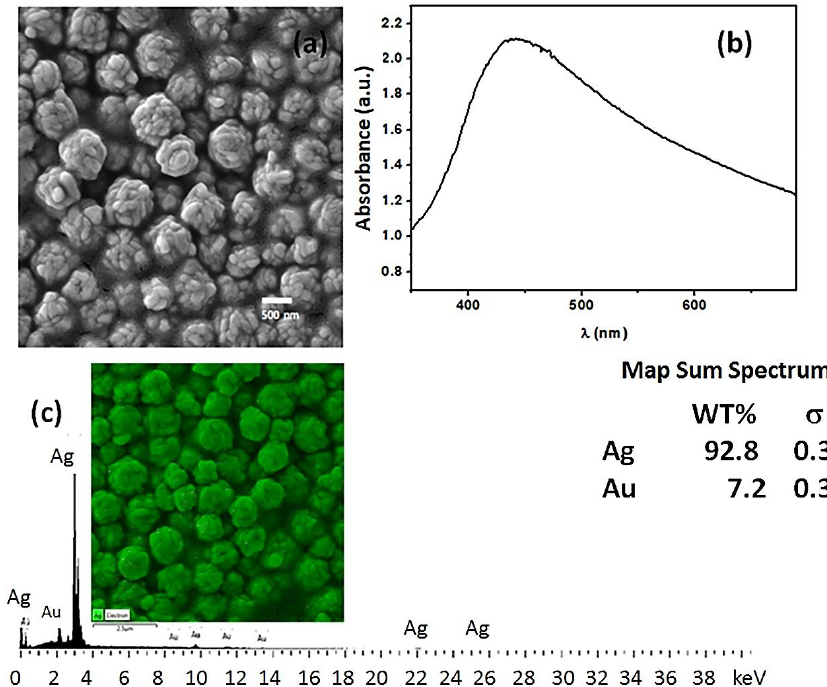
Figure 6. ( a ) SEM image of an SFNP; ( b ) absorbance of visible and UV spectra of light by SFNPs; and ( c ) energy-dispersive X-ray spectroscopy (EDS) of the same components, which are represented in the SEM image. The green color shows the silver particles. Reprinted with permission from [152]. Copyright © 2019, Elsevier.